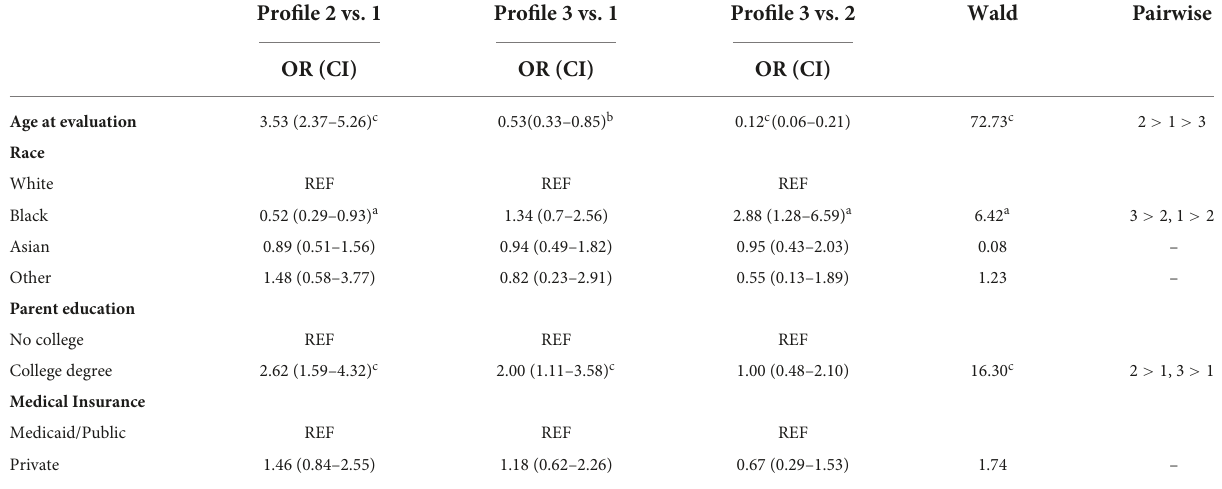
TABLE 4 Parameter estimates of the sociodemographic factors multinomial logistic regression model.